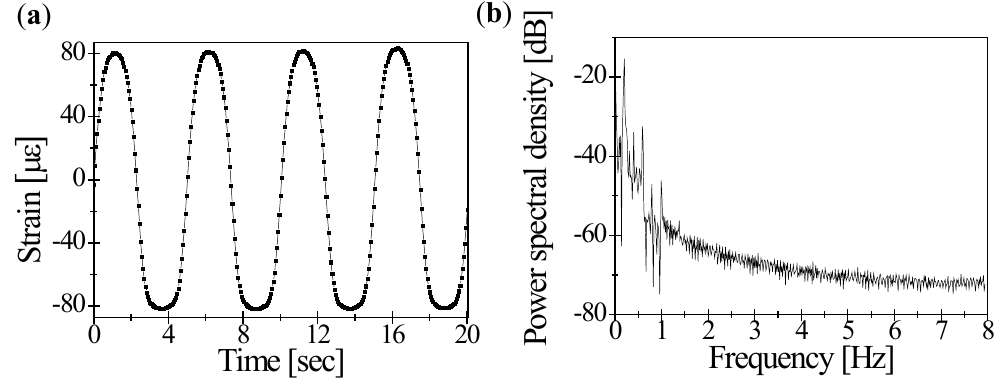
Figure 7. ( a ) The measured dynamic strain response of FBG for applied 0.2 Hz sinusoidal voltage to PZT actuator ( b ) and its PSD FFT